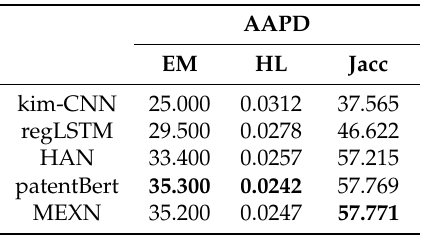
Table 5. Comparisons on AAPD validation